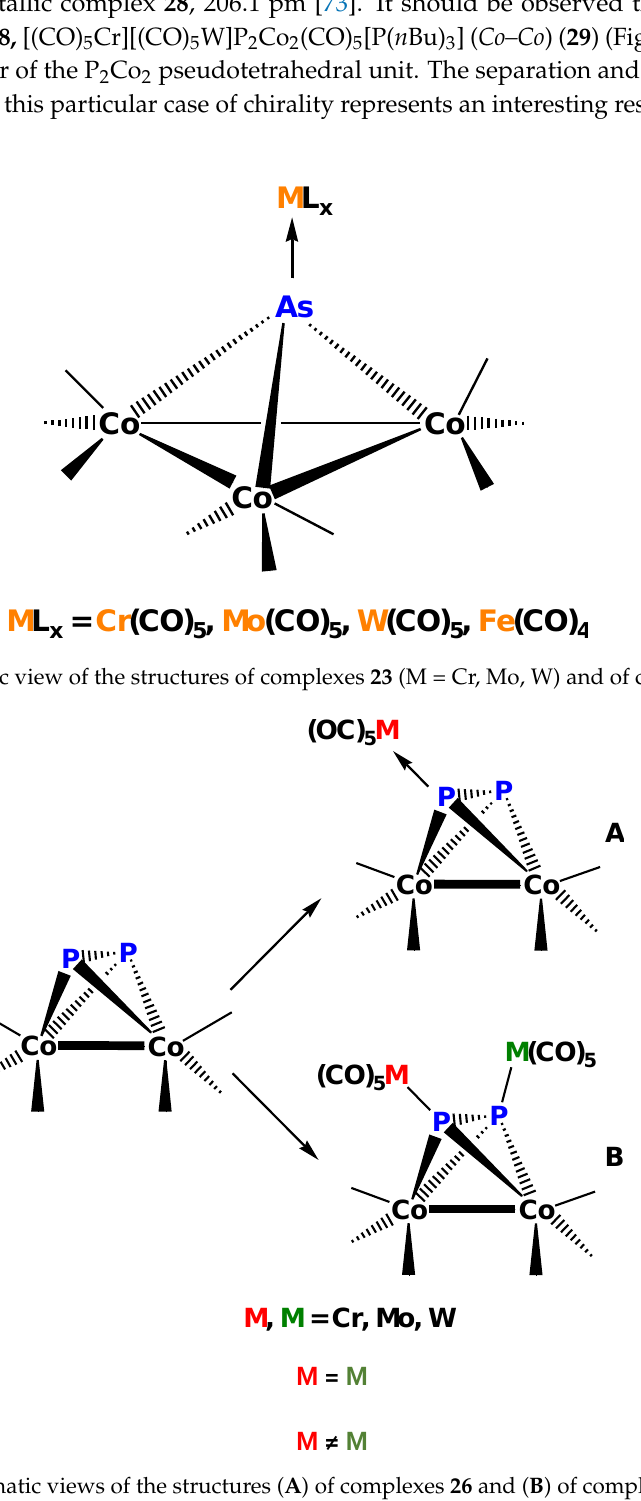
Figure 17. X-ray structure of complex 28 [73].